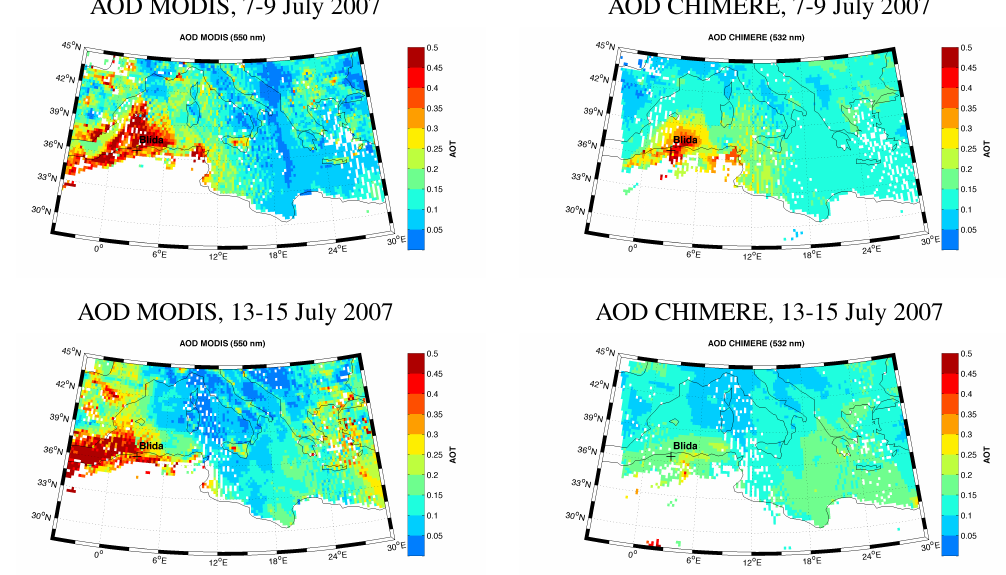
Fig. 11. Maps of mean AOD by MODIS (550nm) and CHIMERE (532nm) during the 7–9 and 13–15 July 2007 dust events. MODIS data are re-gridded to the resolution of the model.